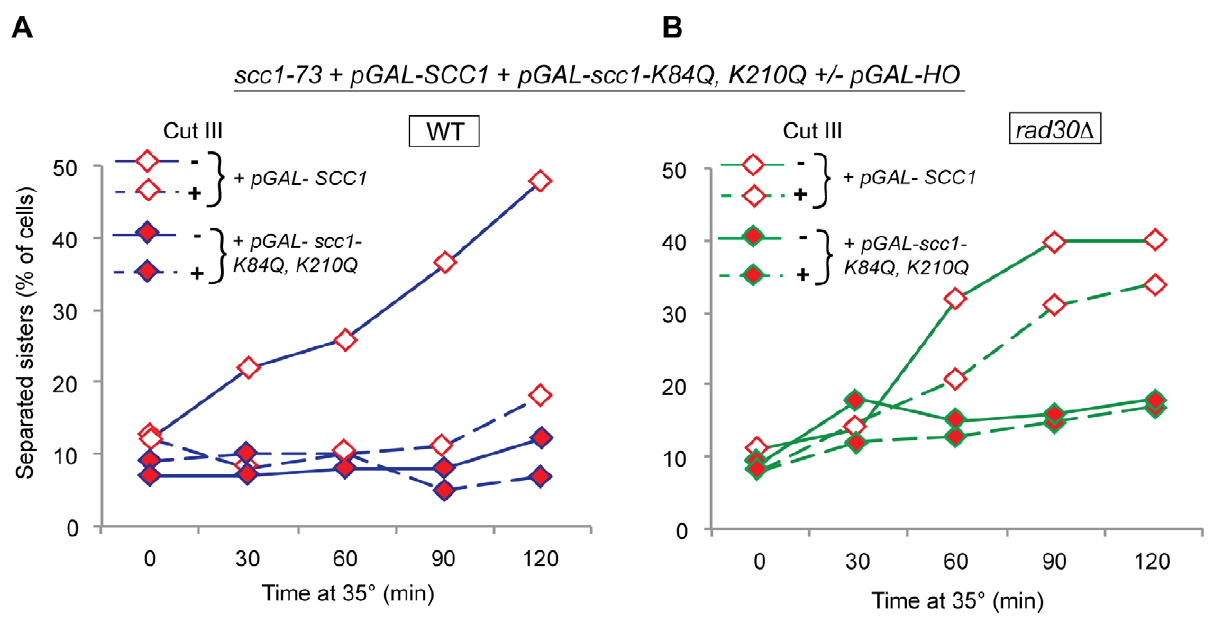
Figure 7. Implications for the action of Pol g in Eco1-dependent acetylation of Scc1. (A) Formation of DI- cohesion was examined using the experimental system described in Figure 1C, except that instead of smc1 ts a ts allele of the Scc1 component of cohesin was utilized ( scc1-73 ). From introduced plasmids either the pGAL-SCC1 or an acetyl mimic Scc1 version, pGAL-scc1-K84Q, K210Q were expressed. A DSB was induced at the MAT locus on Chr. III by HO in indicated sample series. Sister separation was analyzed in samples collected at the indicated time points, by the TetR-GFP/ Tet-O-system, and separation scored in $ 200 cells per time point. (B) DI-cohesion was determined as in (A) in corresponding strains with rad30 D . (A, B) Blue lines represent WT and green lines rad30 D cells. Dashed lines indicate damage